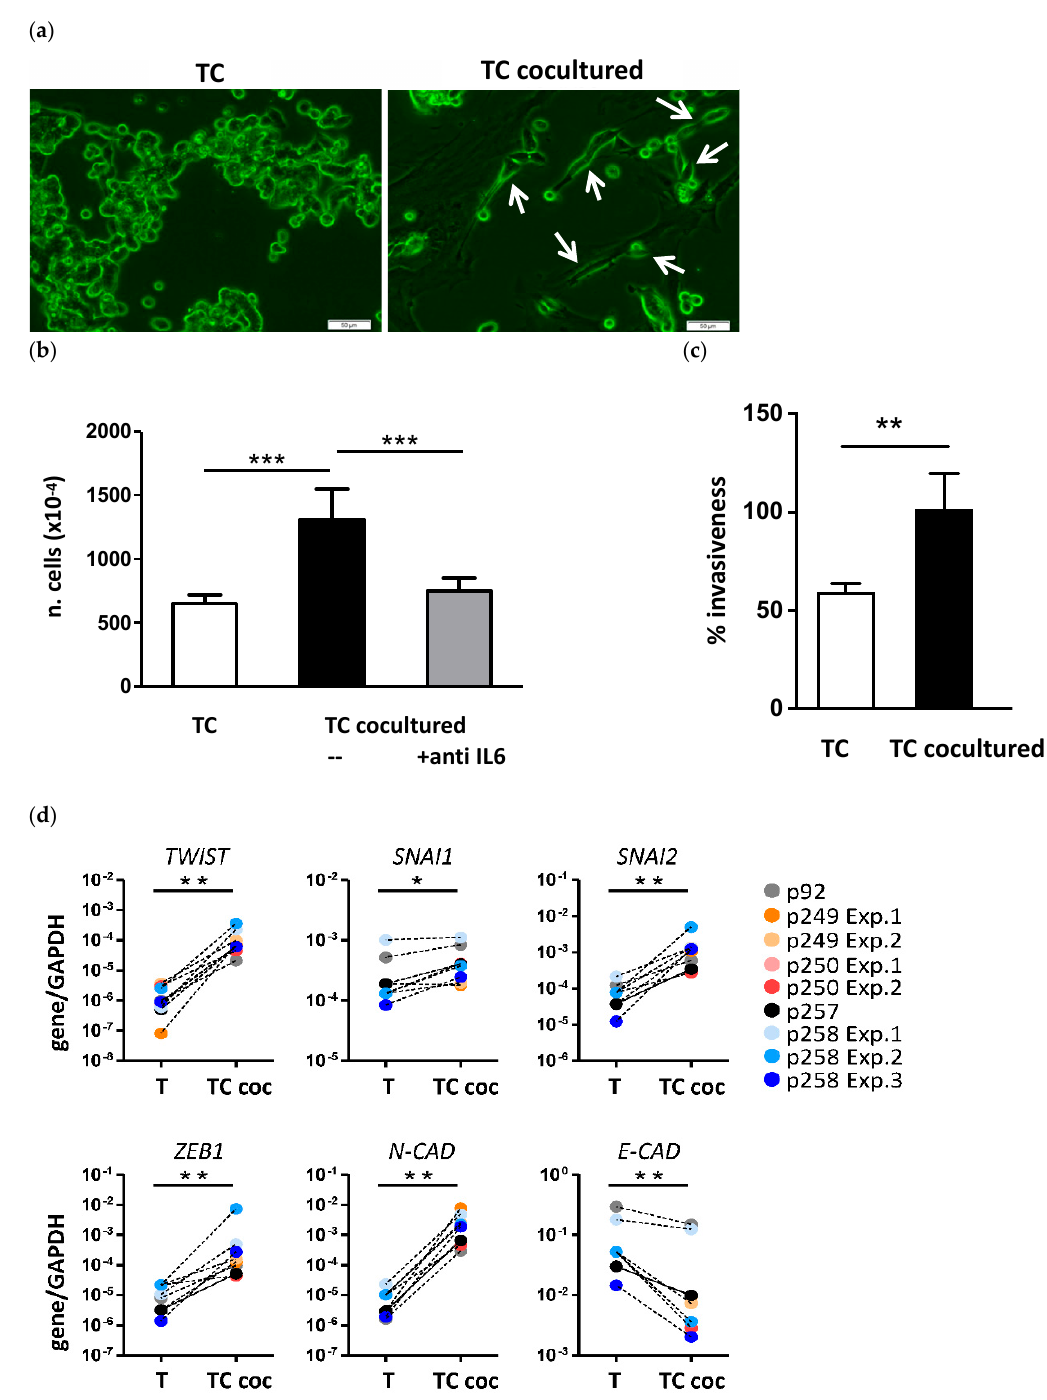
Figure 2 . TASCs promote proliferation and induce EMT in colon cancer cells. ( a ) Morphological modifications observed in GFP/Luc-LS180 cells cultured alone (TC) or with TASCs (TC cocultured) and sorted upon EpCAM staining. Arrows highlight representative events. Magnification 20×; scale bar 50 μ m. ( b ) Numbers of LS180 cells cultured alone (TC) or with TASCs (TC cocultured) in the presence or absence of 10 μ g/mL anti-IL6 neutralizing antibody. Data refer to 8 independent exper- iments performed with two different TASC preparations (Mann–Whitney test, *** p ≤ 0.001). Cell numbers were normalized based on percentages of EpCAM+ and CD90+ cells. ( c ) Invasive capacity of LS180 cells cultured alone (TC) or with TASCs (TC cocultured), as assessed by chemoinvasion